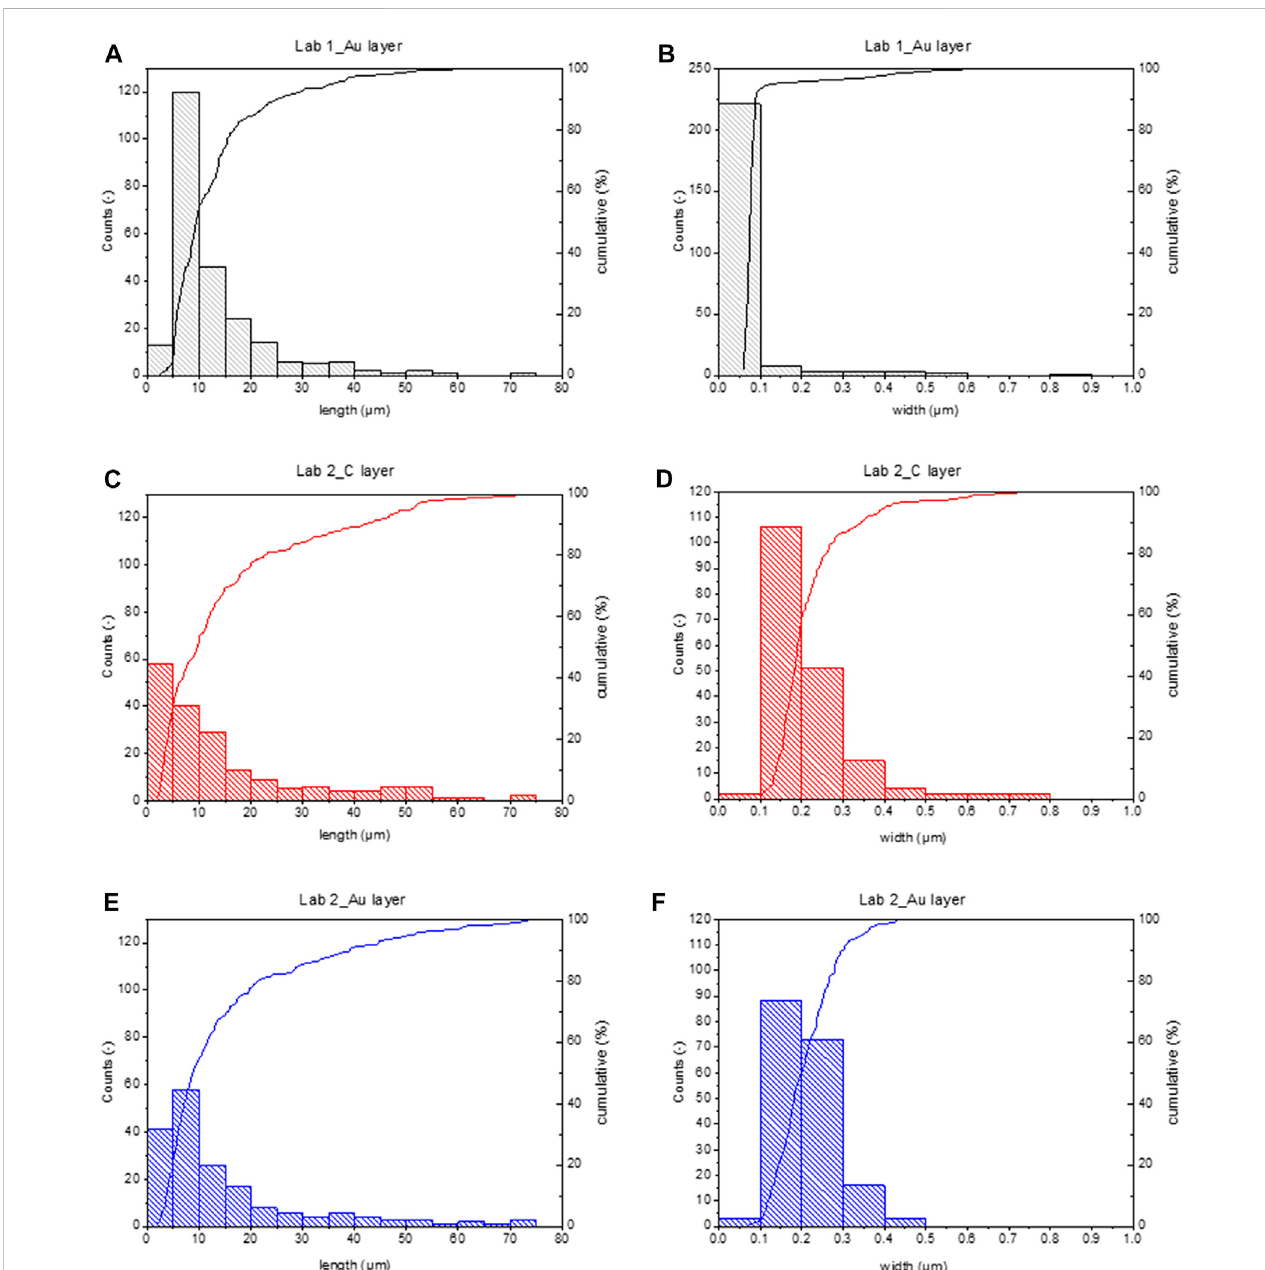
FIGURE 1 Histograms of particle size distribution and cumulative curve calculated measuring fi bres in the analysed water sample, using different setups. All fi bres are considered (even shorter than 5 µm). (A) length and (B) width distributions calculated on Lab 1_Au layer data. (C) length and (D) width distributions calculated on Lab 2_C layer data. (E) length and (F) width distributions calculated on Lab 2_Au layer